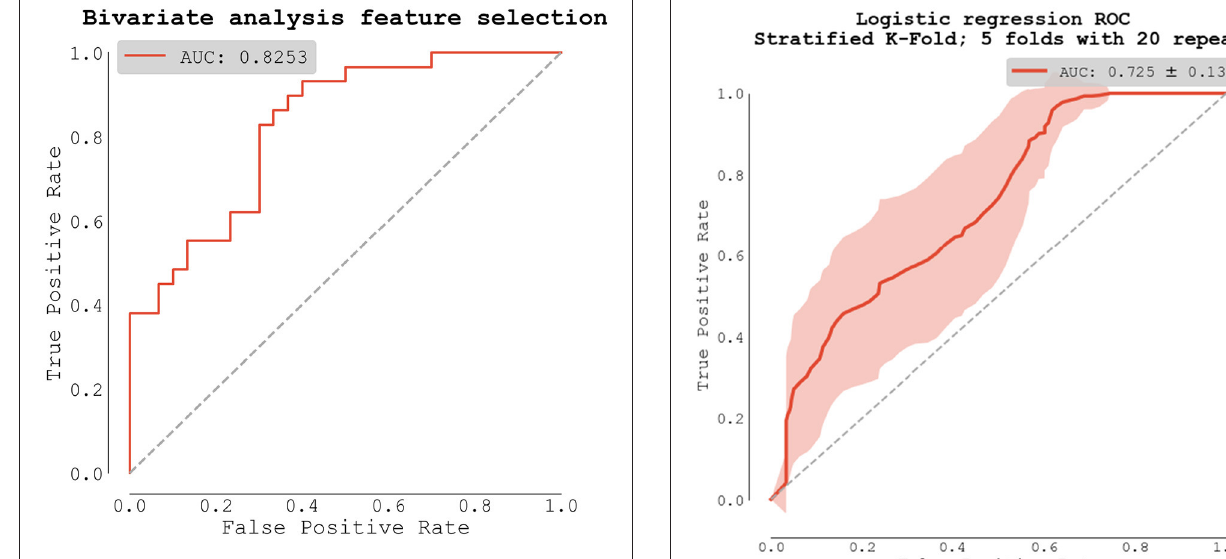
FIGURE 5 | Logistic regression model based on selection from bivariate analysis (predictors with p < 0.1).